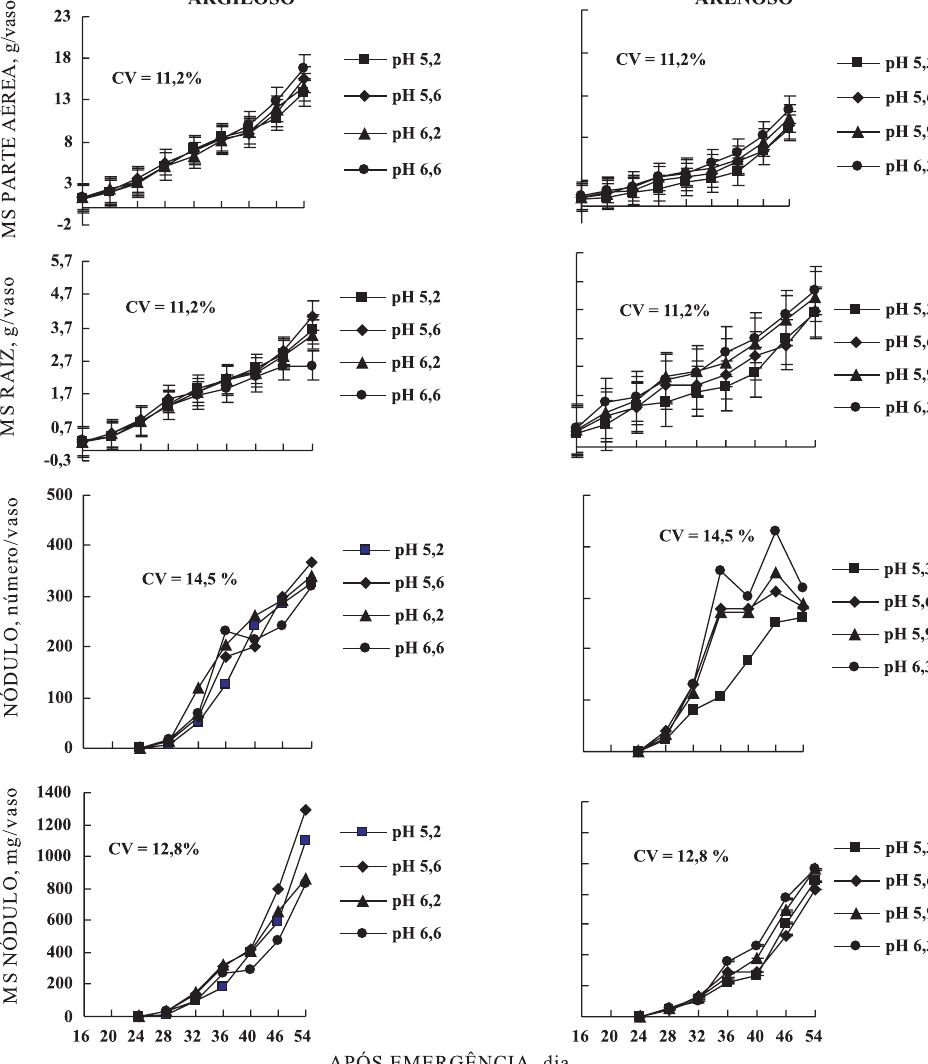
Figura 2. Produção de matéria seca da parte aérea, do sistema radicular e de nódulos e número de nódulos de plantas de soja, em diferentes épocas de avaliação após a emergência, em relação ao pH inicial do solo argiloso e do